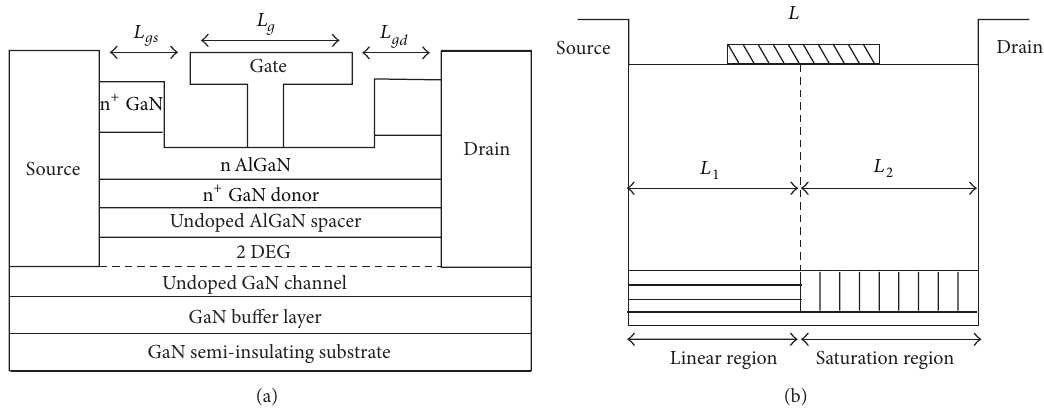
Figure 1: (a) Schematic of AlGaN/GaN MODFET. (b) Diagram for showing linear and saturation region used for 2D